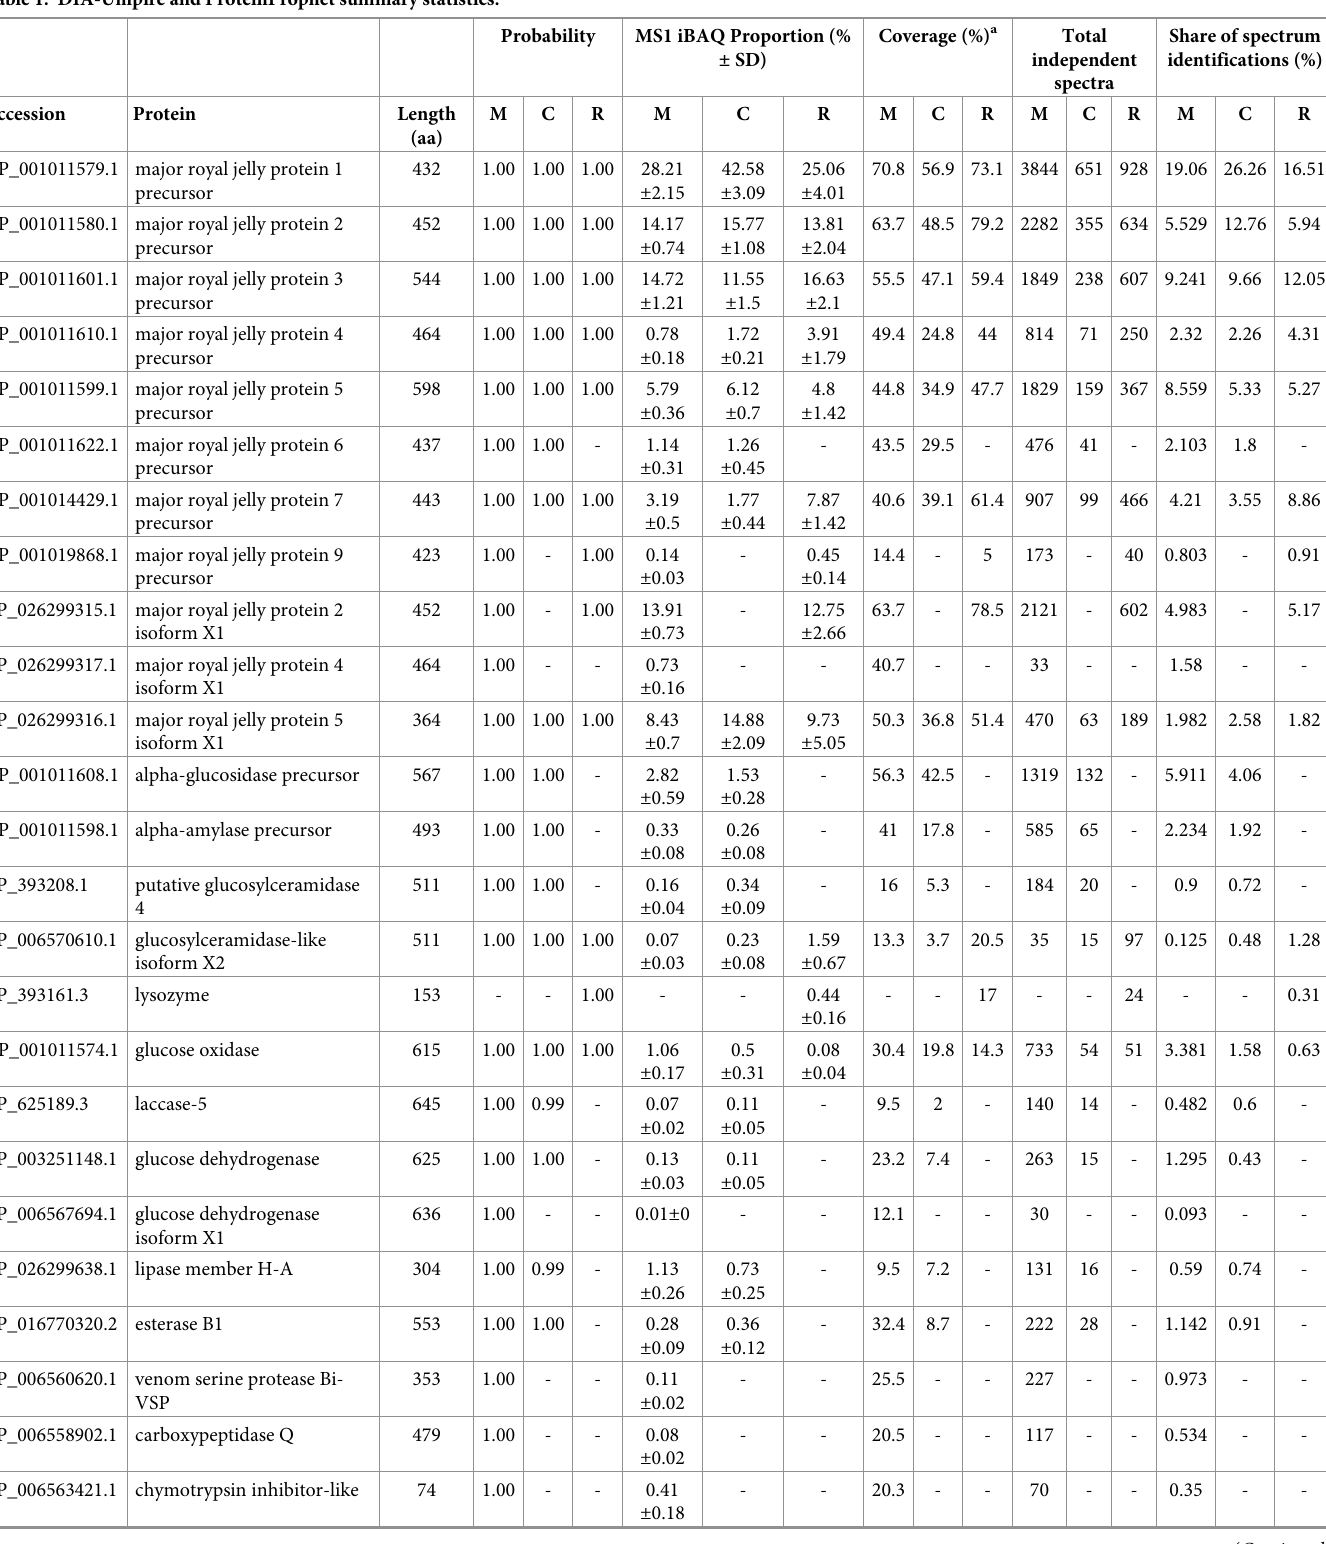
Table 1. DIA-Umpire and ProteinProphet summary